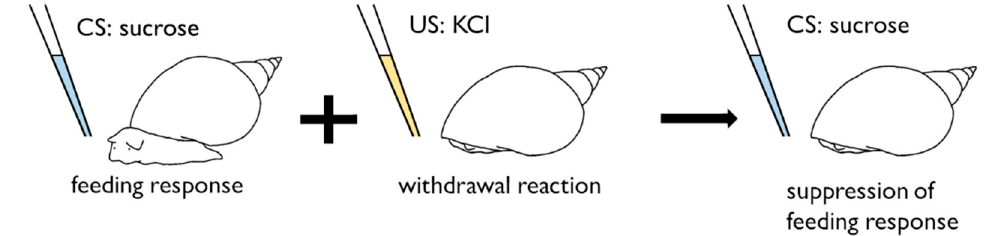
Figure 2. Training protocol of conditioned taste aversion in snails. After a sucrose solution (CS) is